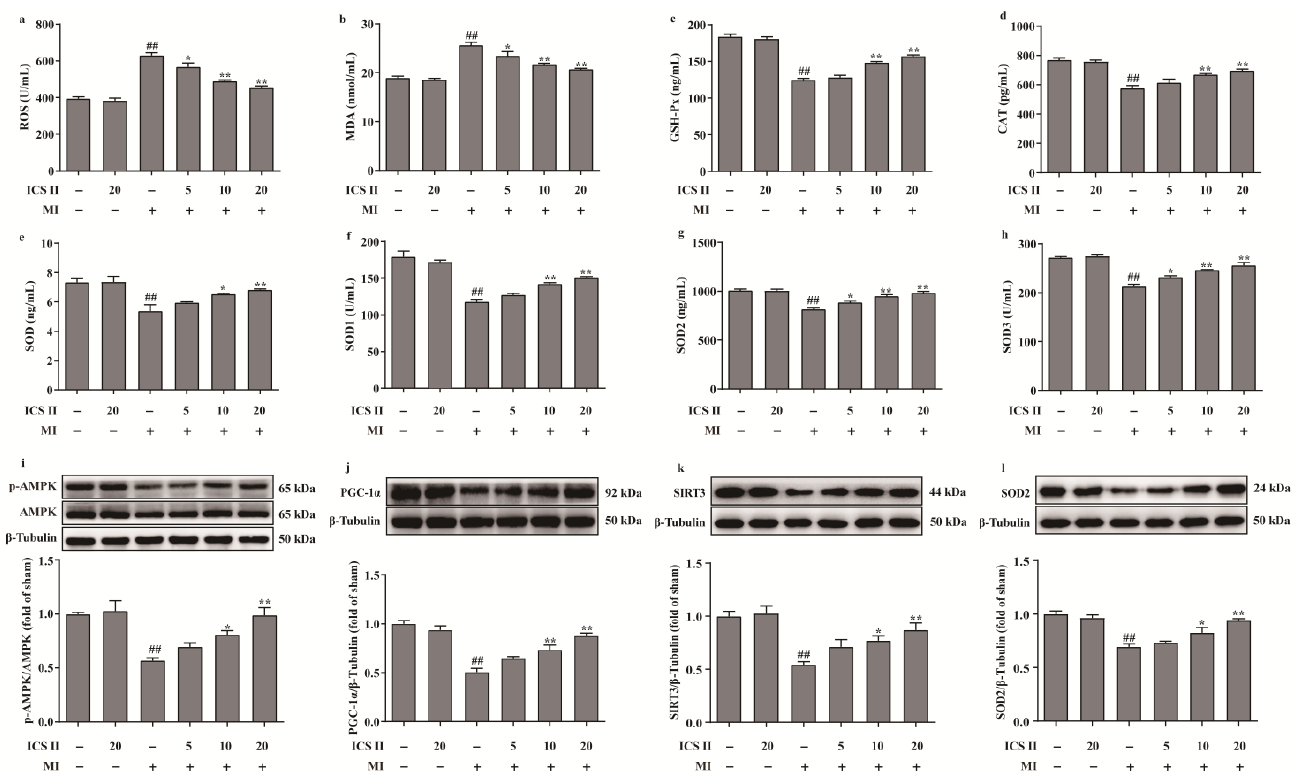
Figure 3. ICS II alleviated oxidative stress injury and activated AMPK/PGC- 1α/SIRT3 signaling pathway in MI-induced mice: ( a ) ROS level ( n = 6); ( b ) MDA level ( n = 6); ( c ) GSH-Px activity ( n = 6); ( d ) CAT activity ( n = 6); ( e ) SOD activity ( n = 6); ( f ) SOD1 activity ( n = 6); ( g ) SOD2 activity ( n = 6); ( h ) SOD3 activity ( n = 6); ( i ) expression and quantitation of p-AMPK ( n = 5); ( j ) expression and quantitation of PGC- 1α ( n = 5); ( k ) expression and quantitation of SIRT3 ( n = 5); ( l ) expression and quantitation of SOD2 ( n = 5). The data are presented as the mean ± SEM. ## p < 0.01 vs. sham; * p < 0.05, ** p < 0.01 vs. MI.